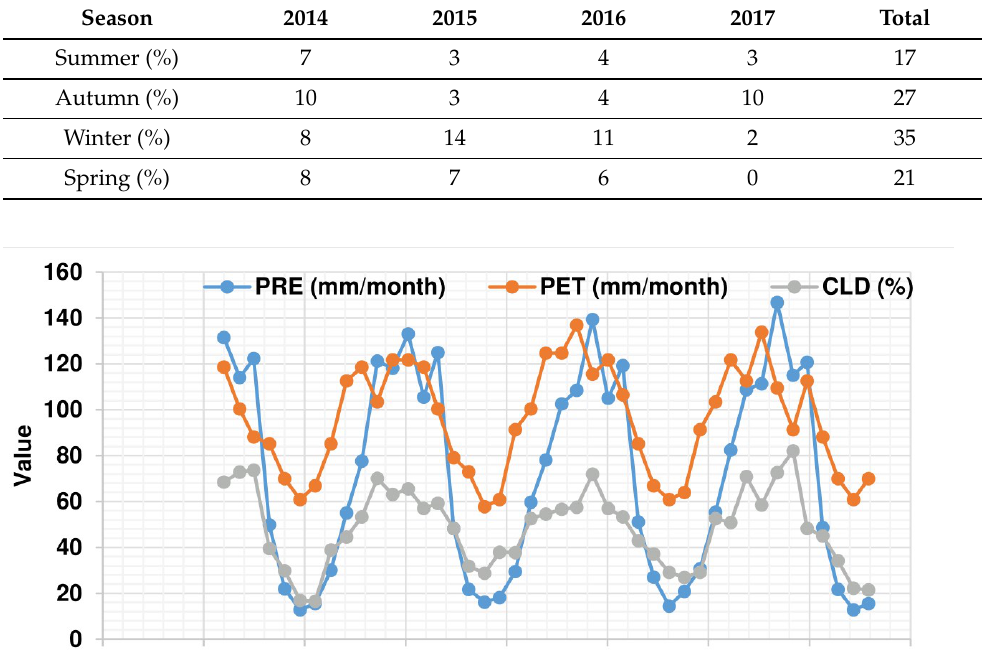
Figure 3. Historical trend of PRE, PET and CLD.